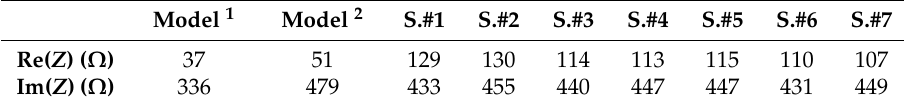
Figure 9. The ink-jet printed flexible antenna: ( a ) UHF and HF tag antennas under manufacturing process; ( b ) HF tag antenna under tests. process; ( b ) HF tag antenna under tests. Table 2. Impedance of ink-jet printed flexible antenna dedicated to the UHF